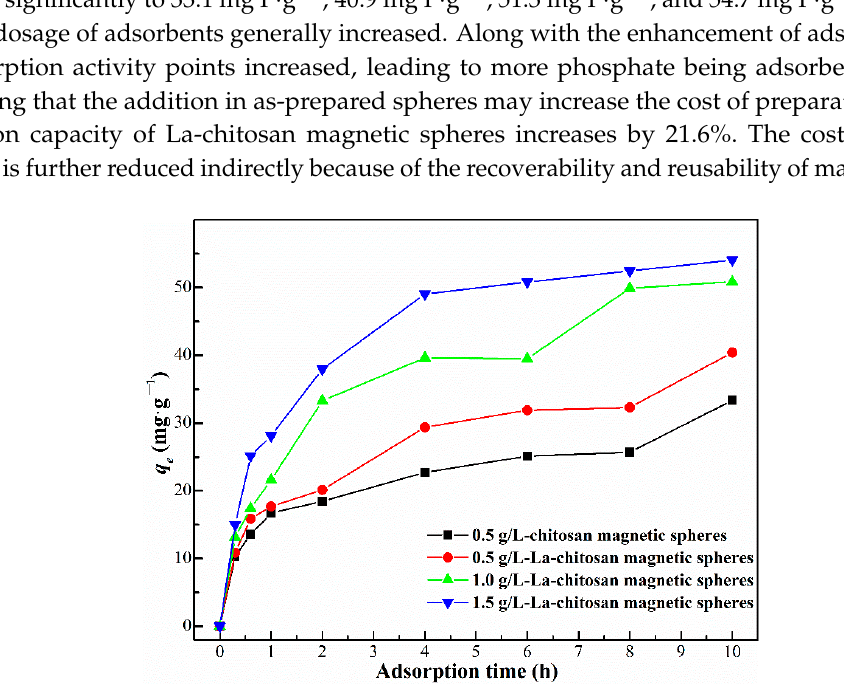
Figure 9. Effect of dosage of La-chitosan magnetic spheres on the phosphate adsorption capacity.